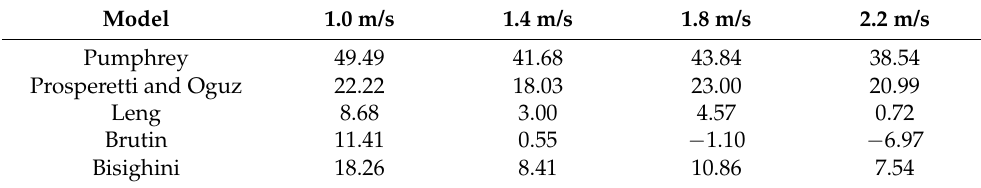
Table 3. Deviation between the maximum dimensionless crater depths predicted from the literature models and the minimum values of the quantity calculated from the simulations at the different